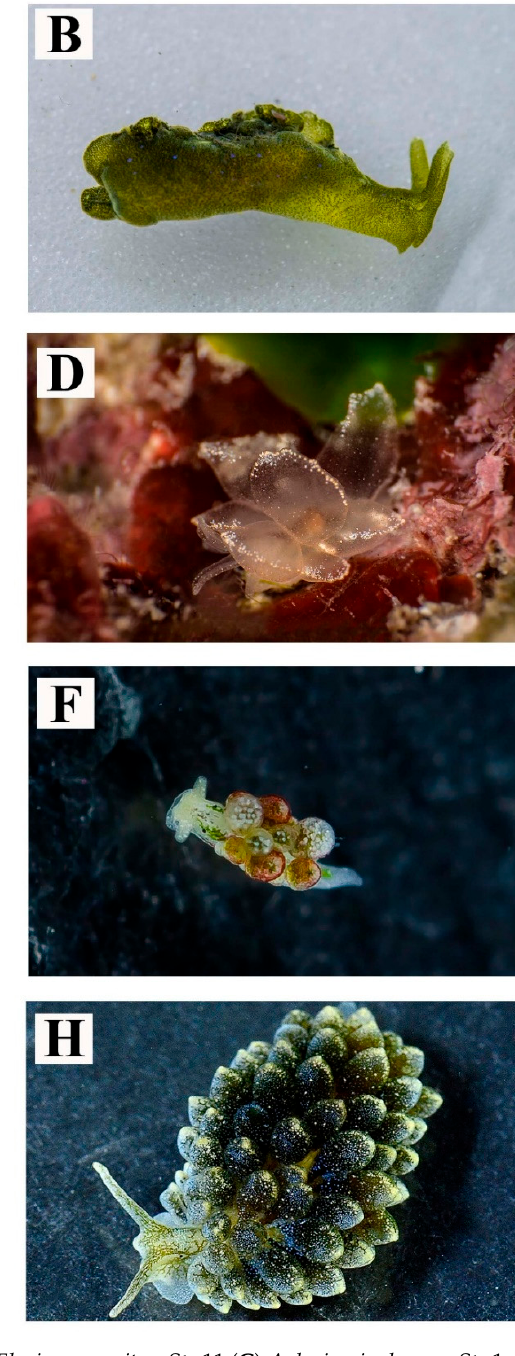
Figure 8. ( A ) Spawn of Elysia gordanae . St. 22 ( B ) Elysia margaritae . St. 11 ( C ) Aplysiopsis elegans . St. 1 Figure 8. A. Spawn of Elysia gordanae . St. 22 B. Elysia margaritae . St. 11 C. Aplysiopsis elegans. St. 1 D. ( D ) Cyerce graeca . St. 11 ( E ) Hermaea bifida . St. 1 ( F ) Hermaea paucicirra . St. 7 ( G , H ) Ercolania coerulea . Cyerce graeca . St. 11 E. Hermaea bifida. St. 1 F. Hermaea paucicirra . St. 7 G. H. Ercolania coerulea . St. 7. St.